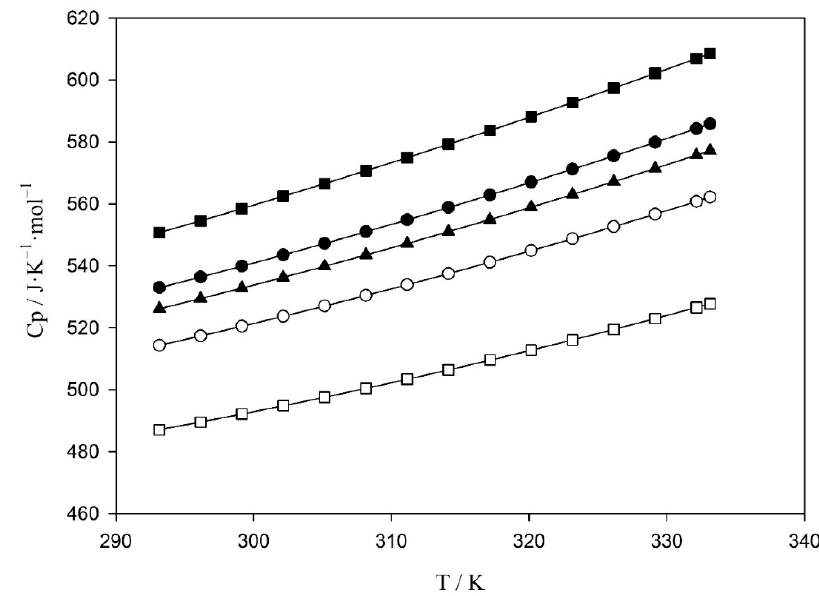
Figure 4. Experimental molar heat capacities, Cp, as a function of temperature for the equimolar binary mixtures: ( ○ ) (1,3) BMimTFO + (1,3) BMimNTf 2 ; ( □ ) (1,3) BMimDCA + (1,3) BMimNTf 2 ; ( ▲ ) (1,3) BMpyTFO + (1,3) BMpyNTf 2 ; ( ● ) (1,1) BMpyrTFO + (1,1) BMpyrNTf 2 and ( ■ ) (1,1) PMpipTFO + (1,1) PMpipNTf 2 , solid lines represent the fitting using the Equation (2).